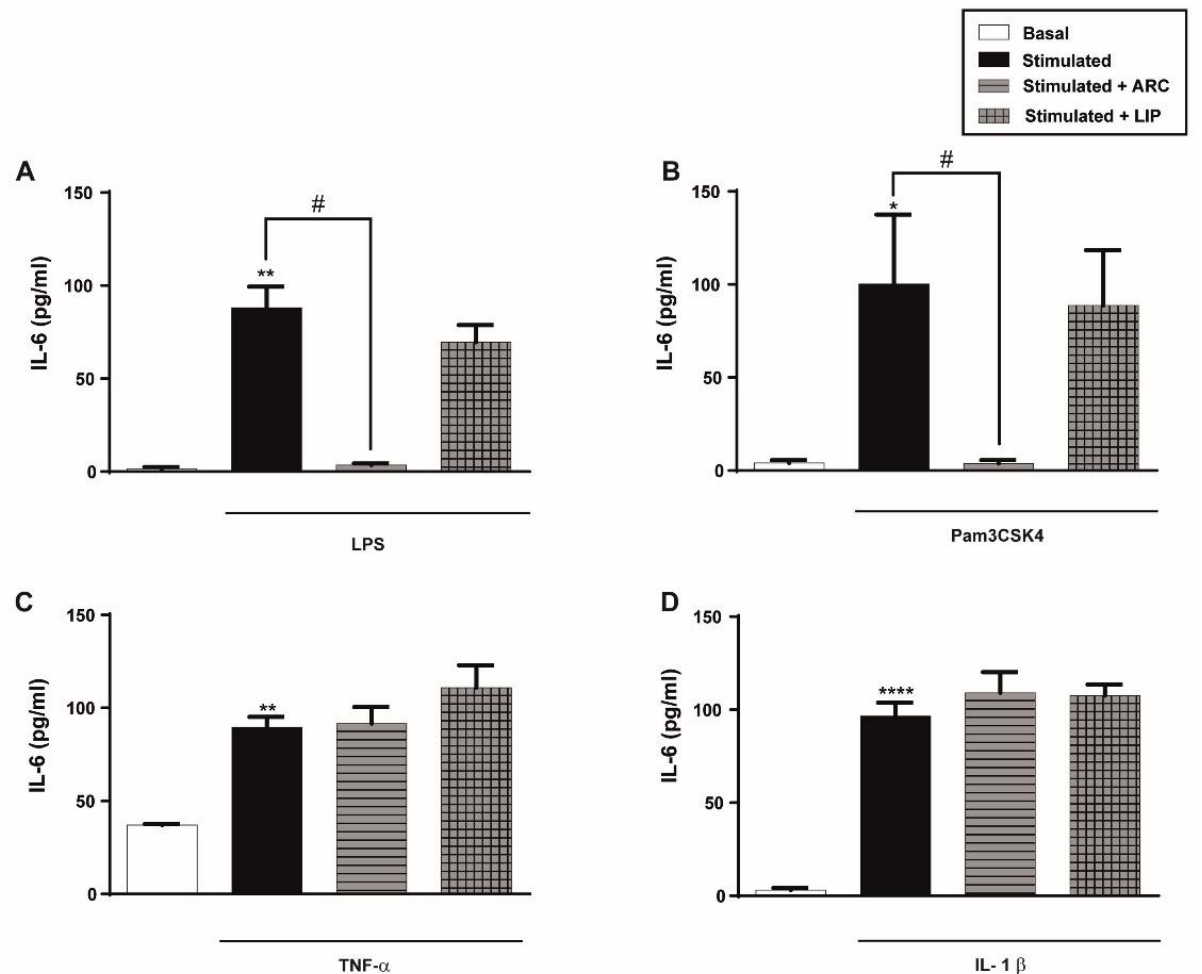
Figure 3. ARC selectively decrease the release of IL-6 by stimulated endothelial cells. HUVEC were stimulated with ( A ) LPS (1 μg /mL); ( B ) Pam3CSK4 (1 μg /mL); ( C ) TNF- α (3 ng /mL) or ( D ) IL-1 β (0.1 ng/mL) and incubated with nanoarchaeosomes (ARC) or liposomes (LIP) at a concentration of 50 μg /mL for 18 h. Concentrations of IL-6 in supernatants were determined by ELISA (one-way ANOVA followed by a Bonferroni multiple comparisons test; * p < 0.05, ** p < 0.01 and **** p < 0.0001 versus basal; # p < 0.05 between labeled groups). Results are the mean ± SEM of four to five inde- pendent experiments.